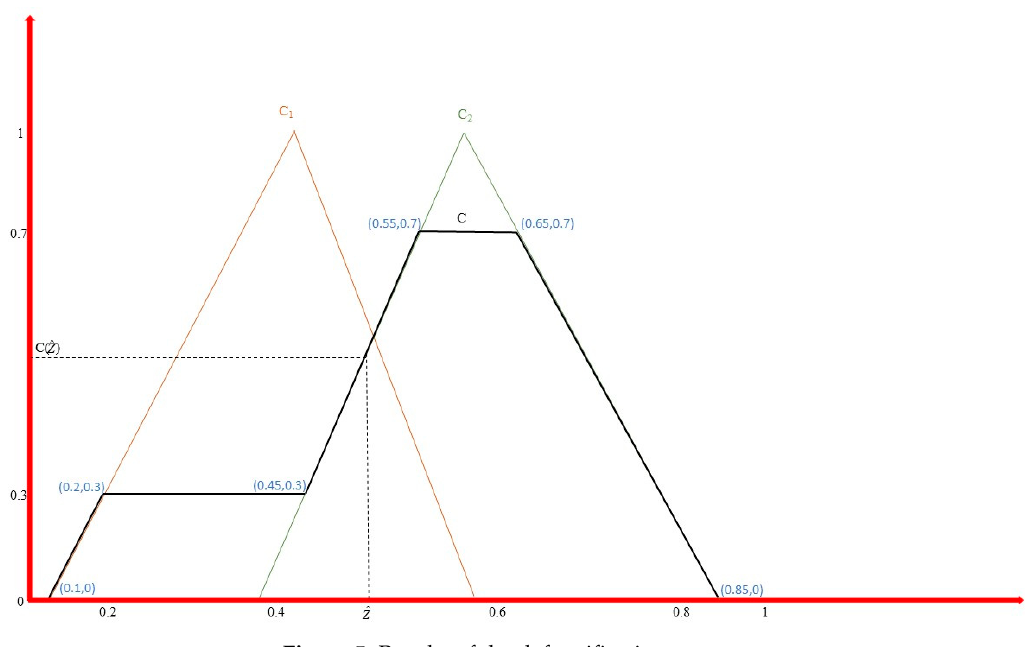
Figure 5. Results of the defuzzification process.